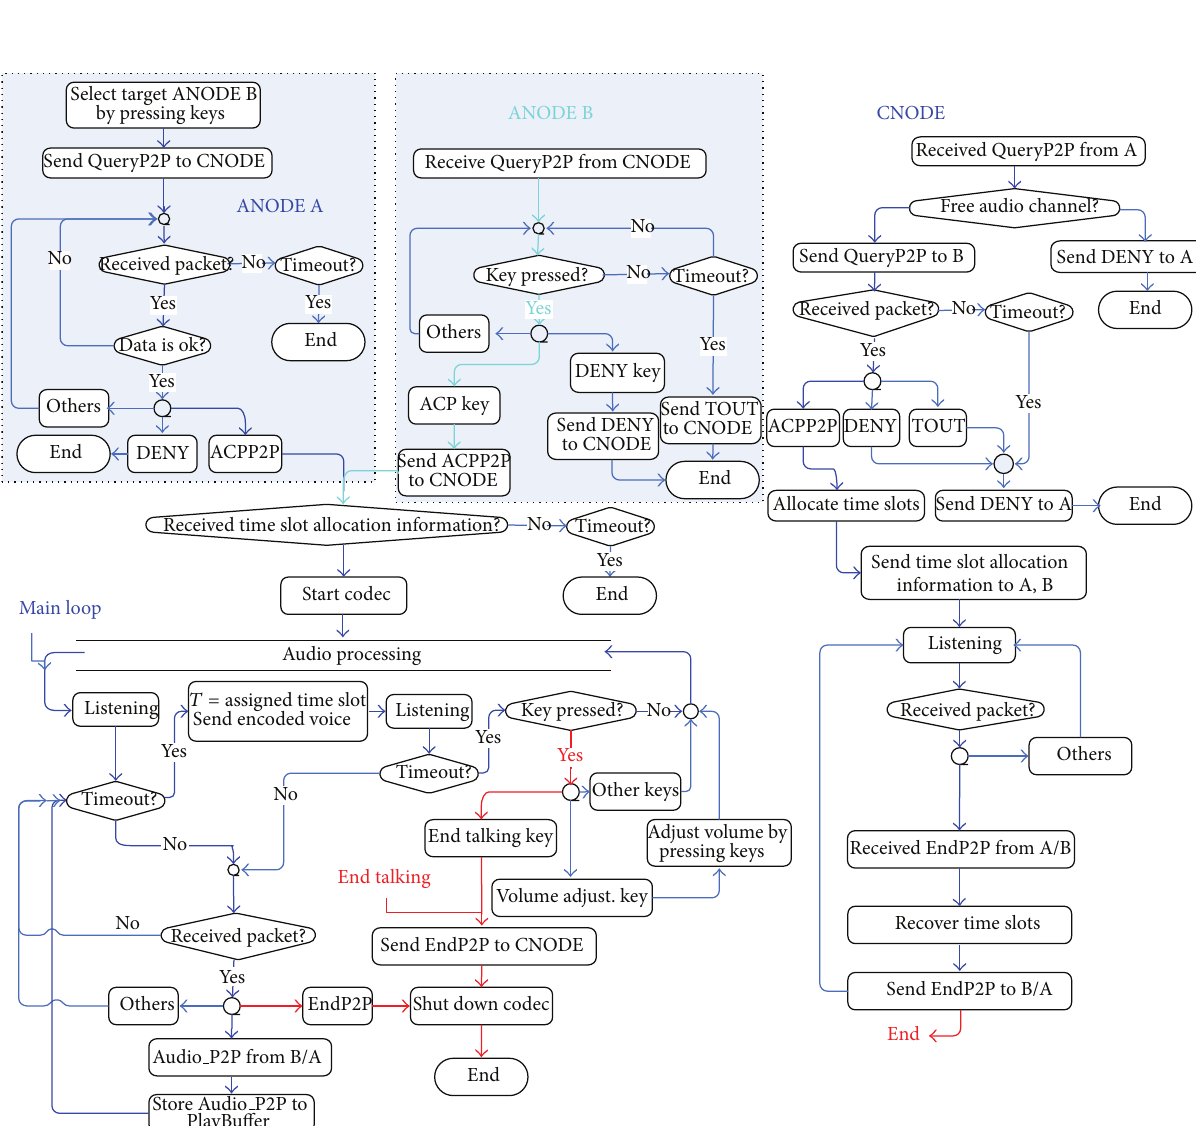
Figure 13: P2P communication